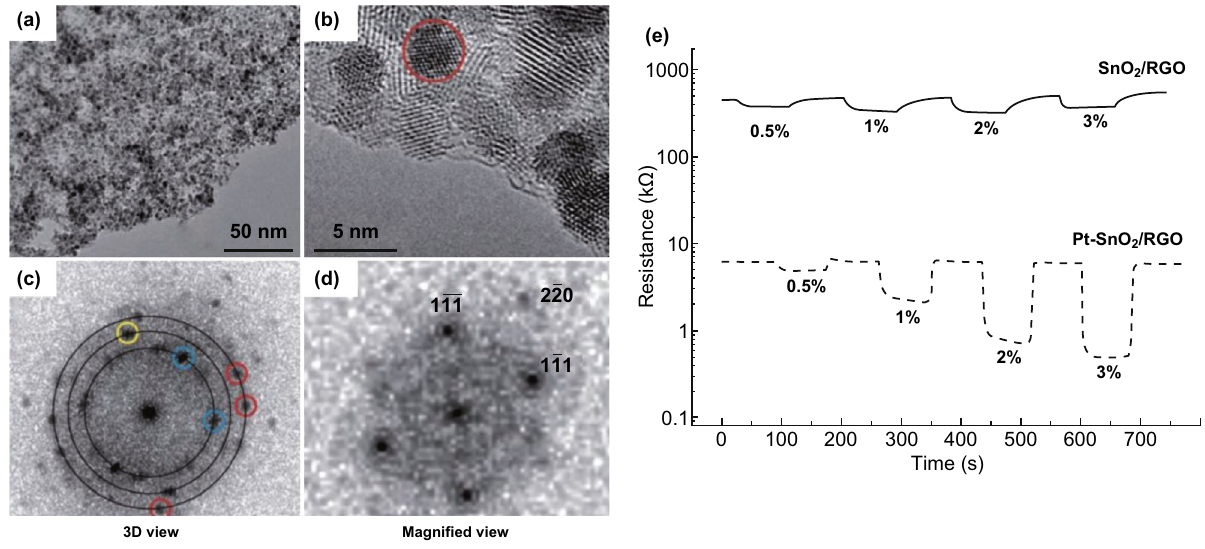
Fig. 18 a TEM and b HRTEM images of Pt-SnO 2 /rGO. Power spectrum of c the whole HRTEM image and d the region of the HRTEM image indicated by the red circle. e Hydrogen-sensing performance at 50 °C of the materials under investigation: variation in the resistance of the rGO/ SnO 2 (solid line) and rGO/SnO 2 /Pt sensors (dashed line) with pulses of hydrogen at 0.5, 1, 2, and 3%. Reproduced with permission [74]. Copy- right 2012,